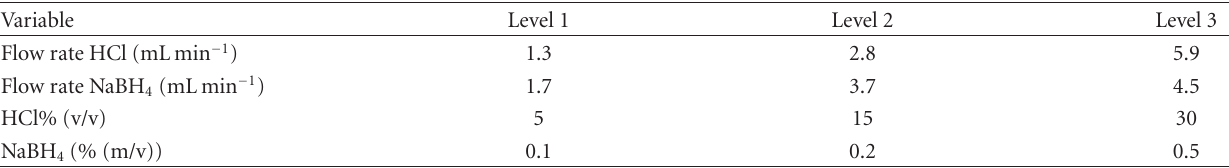
Table 2: Variables and levels for the experimental design.